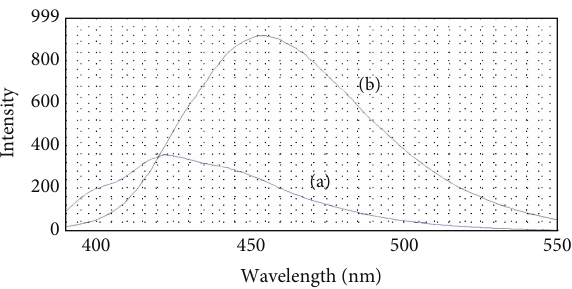
Figure 4: Comparison of emission spectra. (a) The product of OPA reacting with ammonium; (b) the product of MOPA reacting with ammonium.